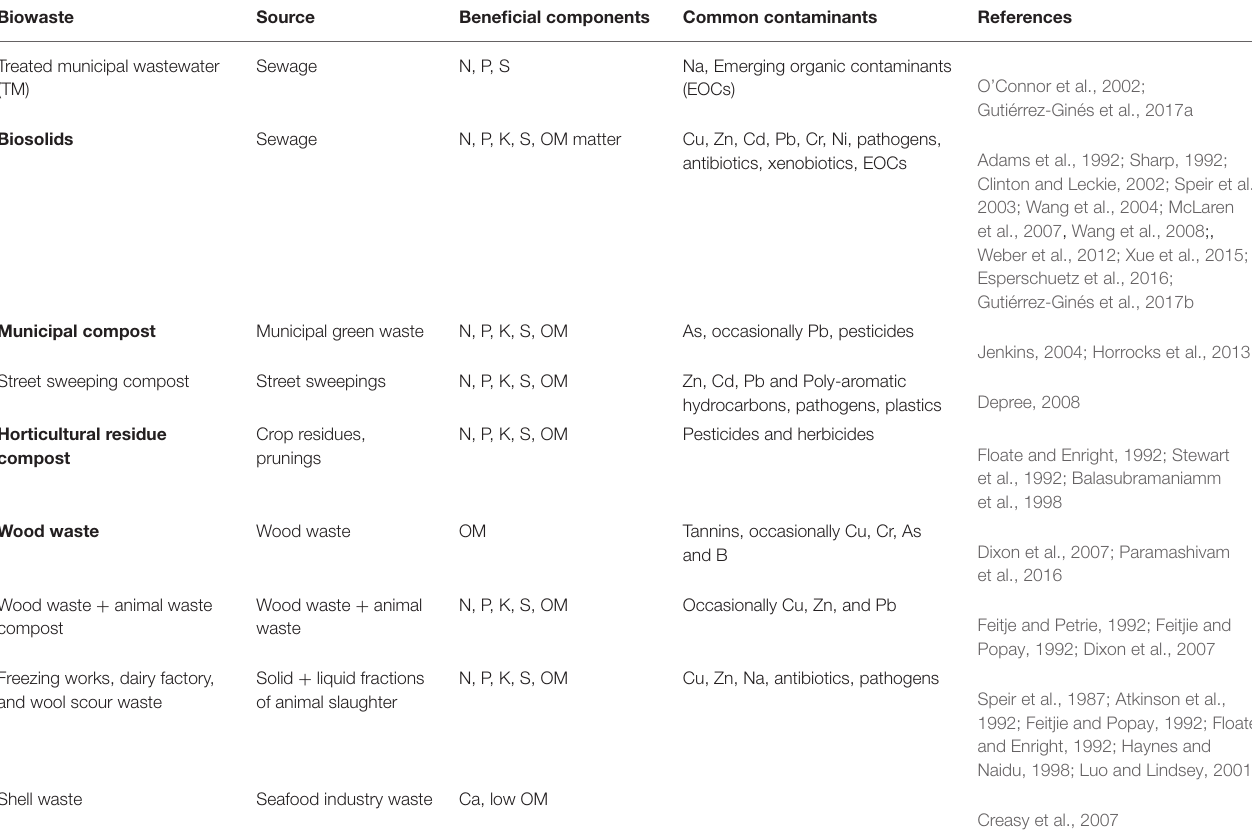
TABLE 1 | Characterisitics of common solid NZ biowastes and Treated Municipal